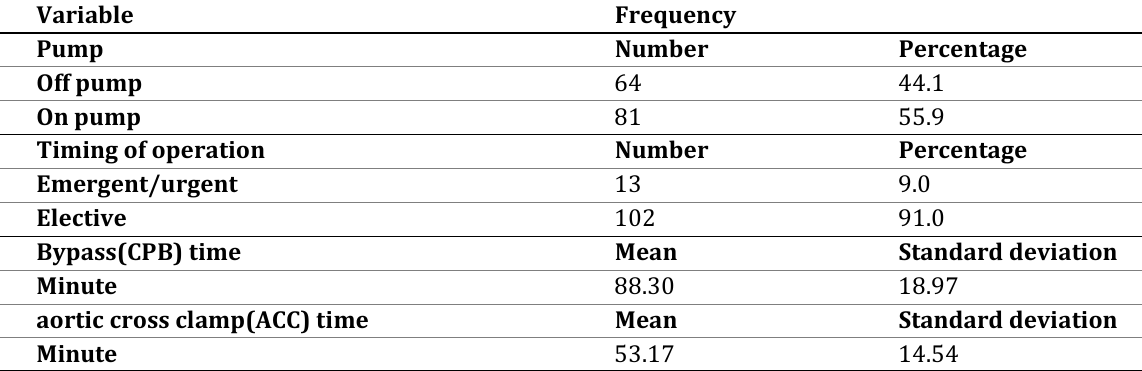
Table 3: Operative data